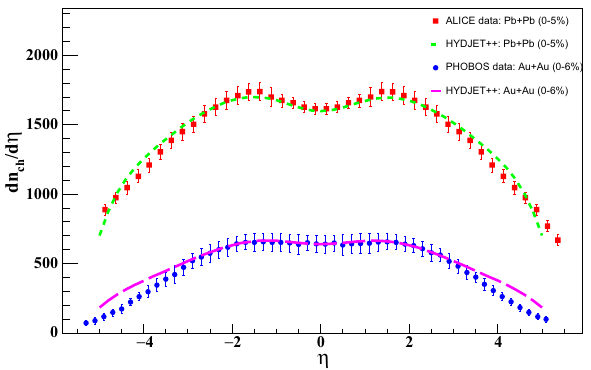
Fig. 8 Variation of dn ch / d η with respect to η is shown for Au + Au and Pb + Pb collisions in most central events. We have also plotted the corresponding experimental data [56,57] for